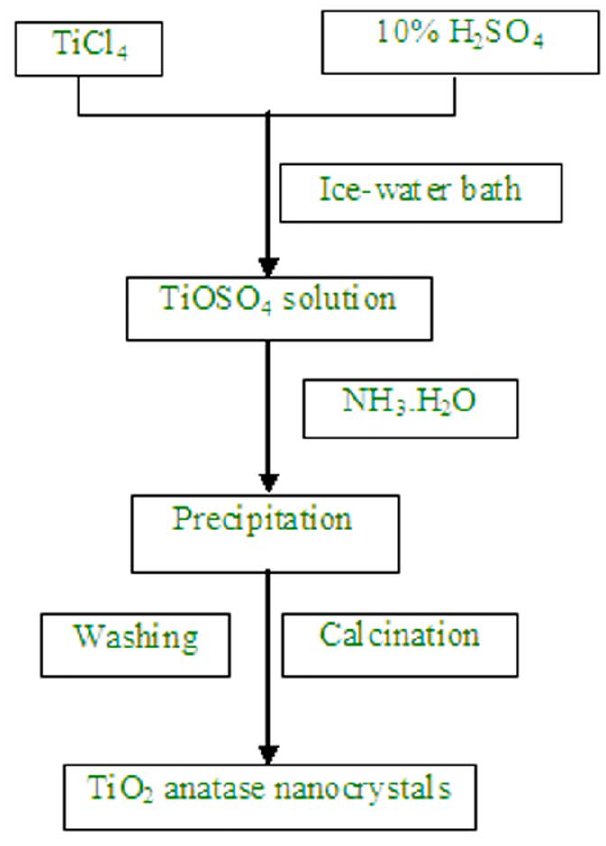
Figure 1. Process of TiO 2 anatase nanocrystals preparation.